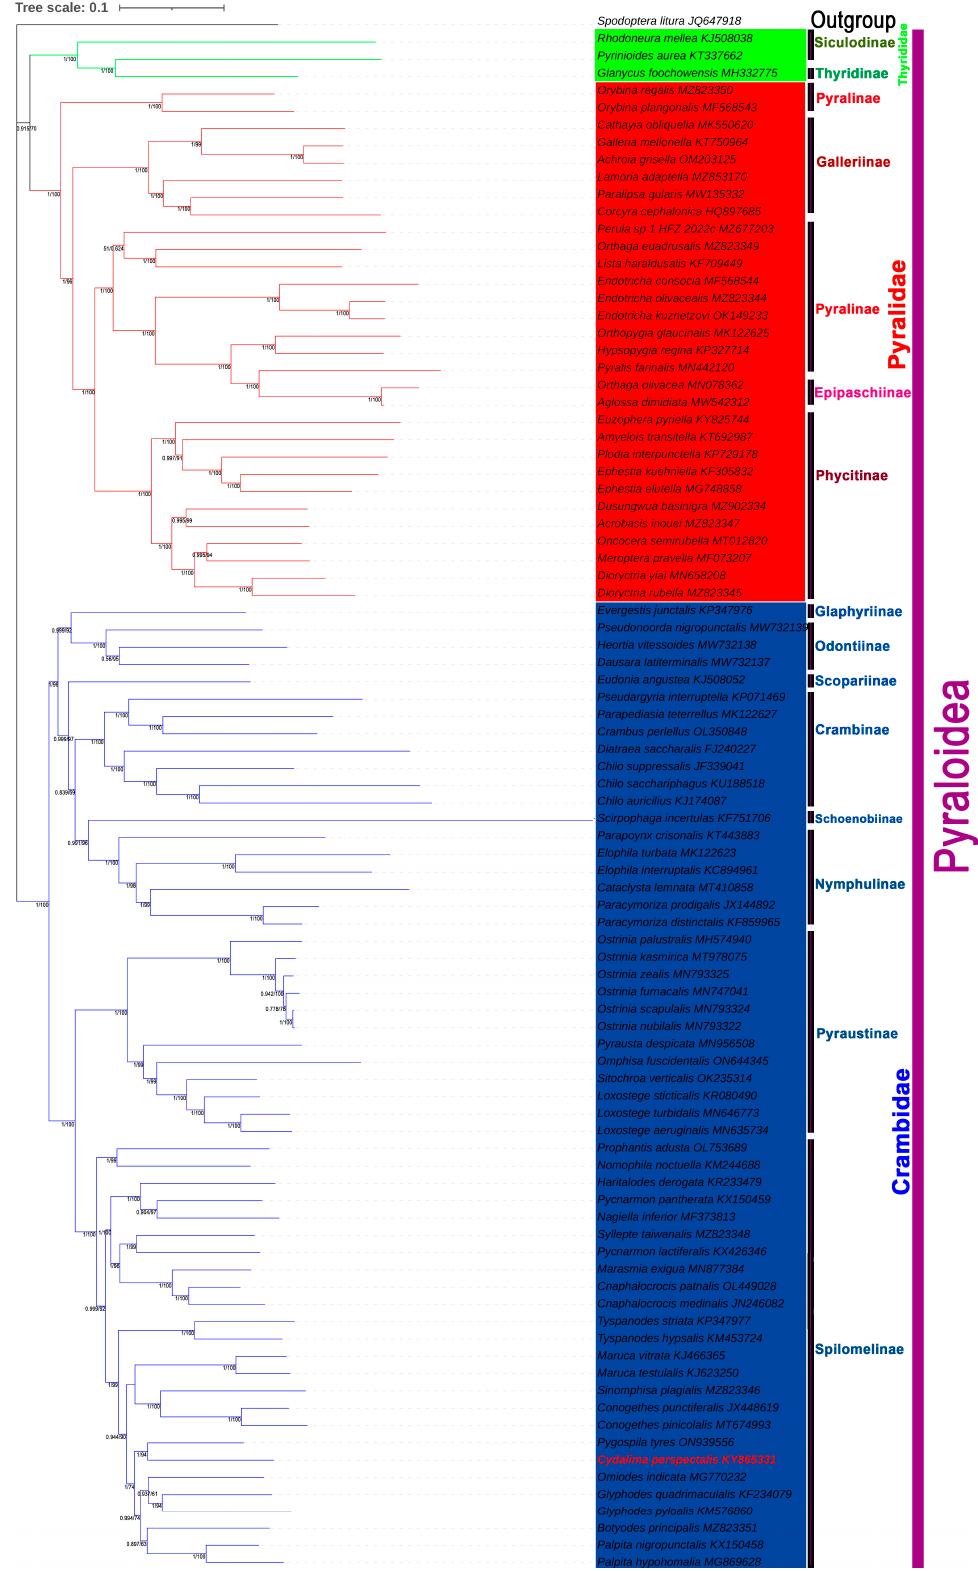
Figure 6. Phylogenetic tree derived for Pyraloidea using Bayesian inference (BI) and maximum likelihood (ML) analyses based on nucleotide (NT). Bootstrap value (BP) and Bayesian posterior probability (BPP) of each node are shown such as BPP based on the NT dataset/BP based on the NT dataset, 1.00/100.